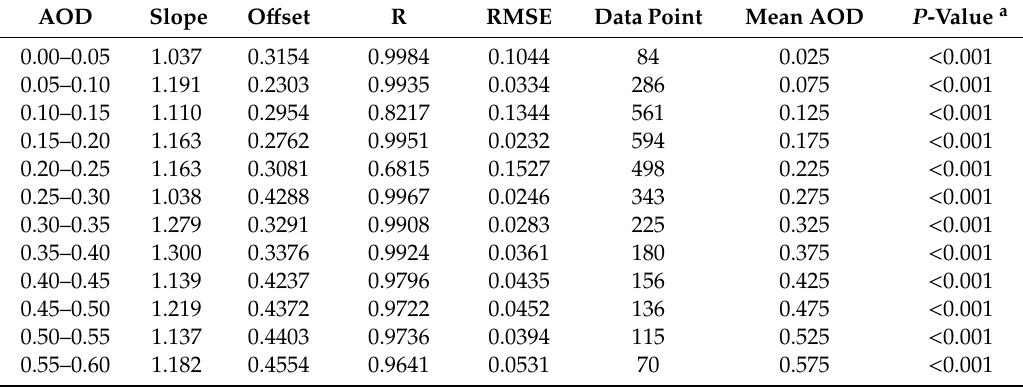
Figure 5. Scatter plots of the PBLH and the relative height difference. The AOD values are denoted by the colored scale. Table 1. The linear relationships between ∆ h and the PBLH for various AOD (aerosol optical depth) levels.